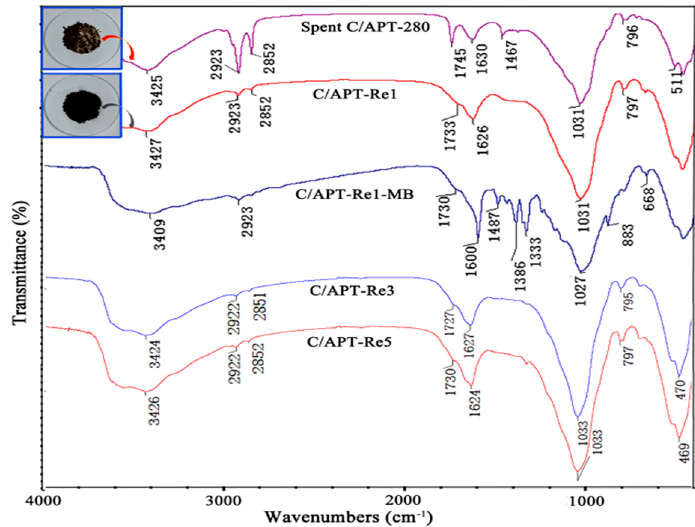
Figure 4. FTIR spectra of the spent C/APT-280 decolorant, C/APT-Re1 and C/APT-Re1-MB, C/APT-Re3 and C/APT-Re5. The inset shows digital photographs of spent C/APT-280 and C/APT-Re1, respectively.